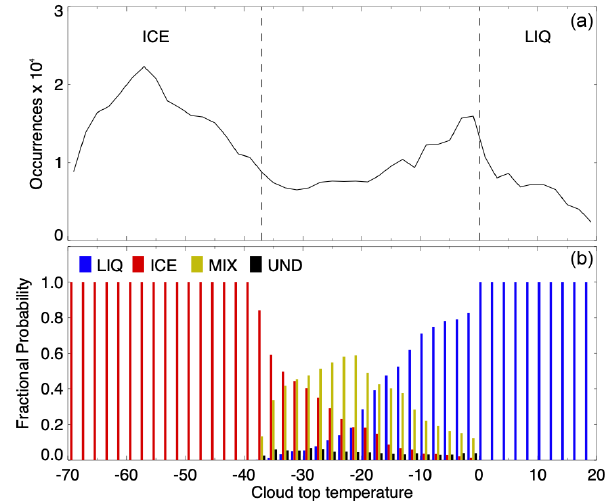
Figure 7. (a) Distribution of volume depolarization ratios for each altitude bin within all detected cloud layers at GSFC (2018–2019). The vertical dashed lines indicate the thresholds for the CPD as de- fined in Table 2. (b) Fractional probability of retrieved cloud phases in 0.01 increments for the volume depolarization ratios shown in (a) . Cloud phases written in lowercase letters of (a) indicate these are altitude bin designations, while phases written in uppercase of (b) represent the layer-determined designations.